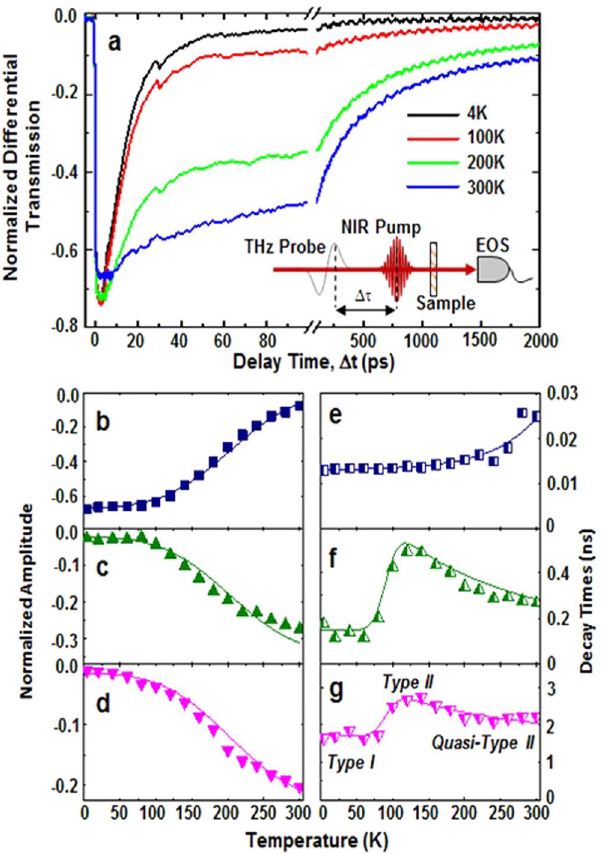
Figure 3. Carrier dynamics of MQW system: ( a ) Normalized differential terahertz (TR-THz) transmission for a range of lattice temperatures. The inset shows the collinear experimental geometry of THz probe and near- infrared (NIR) pump. ( b – d ) and ( e – g ) are the amplitude and decay times of the fast, intermediate, and slow carrier dynamics extracted from fitting the transients. In ( g ) the regions of quasi-type I, type II, and quasi-type II are